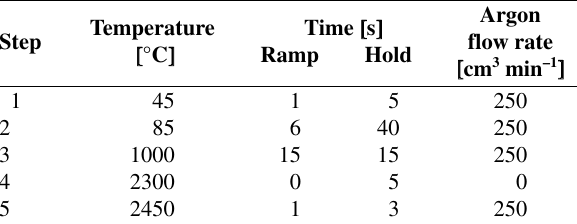
Table 2. Heating program II for the determination of chro- mium(VI) in chloroform with Varian AA-20 GFAAS instrument.